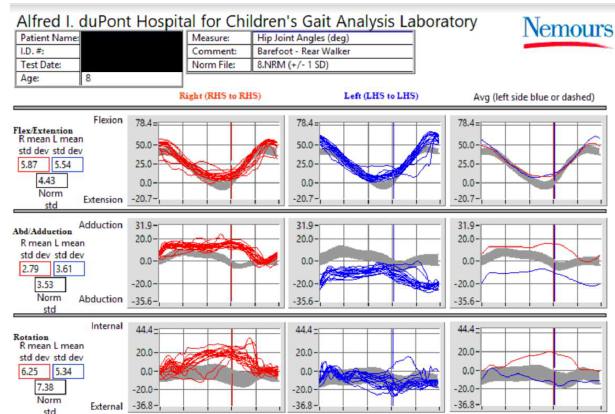
Figure 2 . 3D Instrumented Gait Analysis of Hip Motion During Ambulation for an 8-Year-Old Boy GMFC III with CP. The Patient is Seen with Out-of-Range Motion Compared Against Normal Standard Deviations.